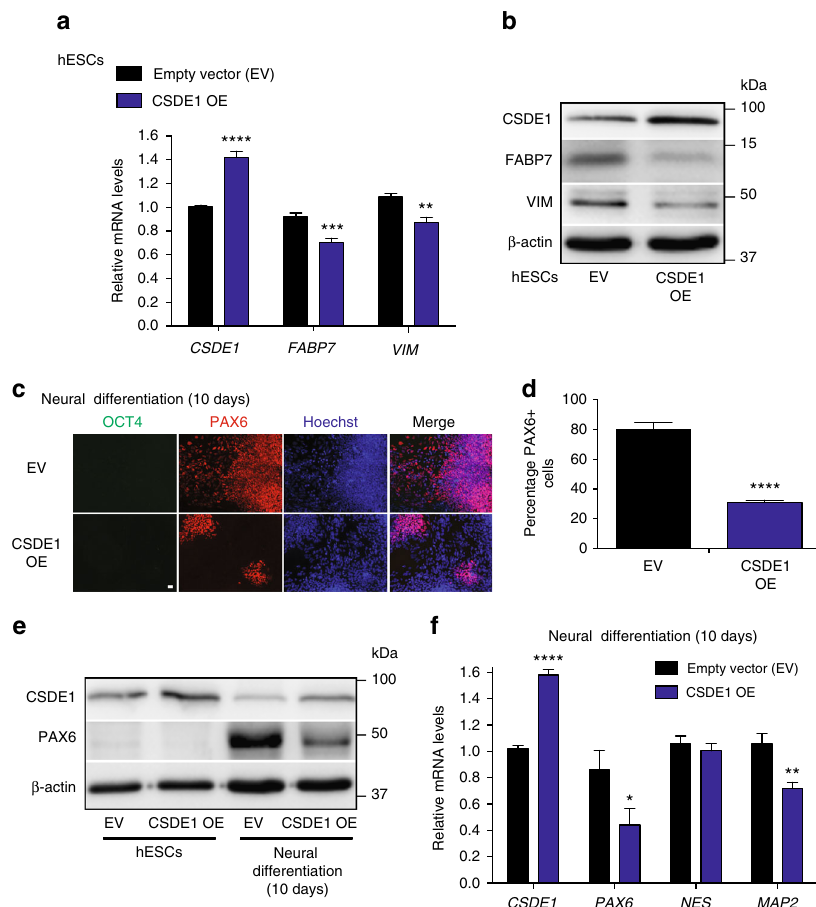
Fig. 7 Ectopic expression of CSDE1 reduces FABP7 levels and impairs neural differentiation. a qPCR analysis of FABP7 and VIM levels (relative expression to EV H9 hESCs) in CSDE1-overexpressing (CSDE1 OE) H9 hESCs. Data represent two independent experiments with three biological replicates. b Western blot analysis of H9 hESCs with antibodies to CSDE1, FABP7 and VIM. β -actin is the loading control. c After 10 days of neural induction, cells were assessed by immuno fl uorescence with OCT4, PAX6, and Hoechst staining. Scale bar represents 20 μ m. d Quanti fi cation of the percentage of PAX6-positive cells/ total nuclei after 10 days of neural induction. Graph represents the mean ± s.e.m. of three independent experiments, 1000 – 1400 total cells per experiment. e Western blot analysis of H9 hESCs and their differentiated counterparts after 10 days of neural induction. f qPCR analysis after 10 days of neural induction. Data (relative expression to EV shRNA cells) represent three independent experiments with three biological replicates. All the statistical comparisons were made by Student ’ s t -test for unpaired samples. P -value: *( P < 0.05), **( P < 0.01), ***( P < 0.001), ****( P <